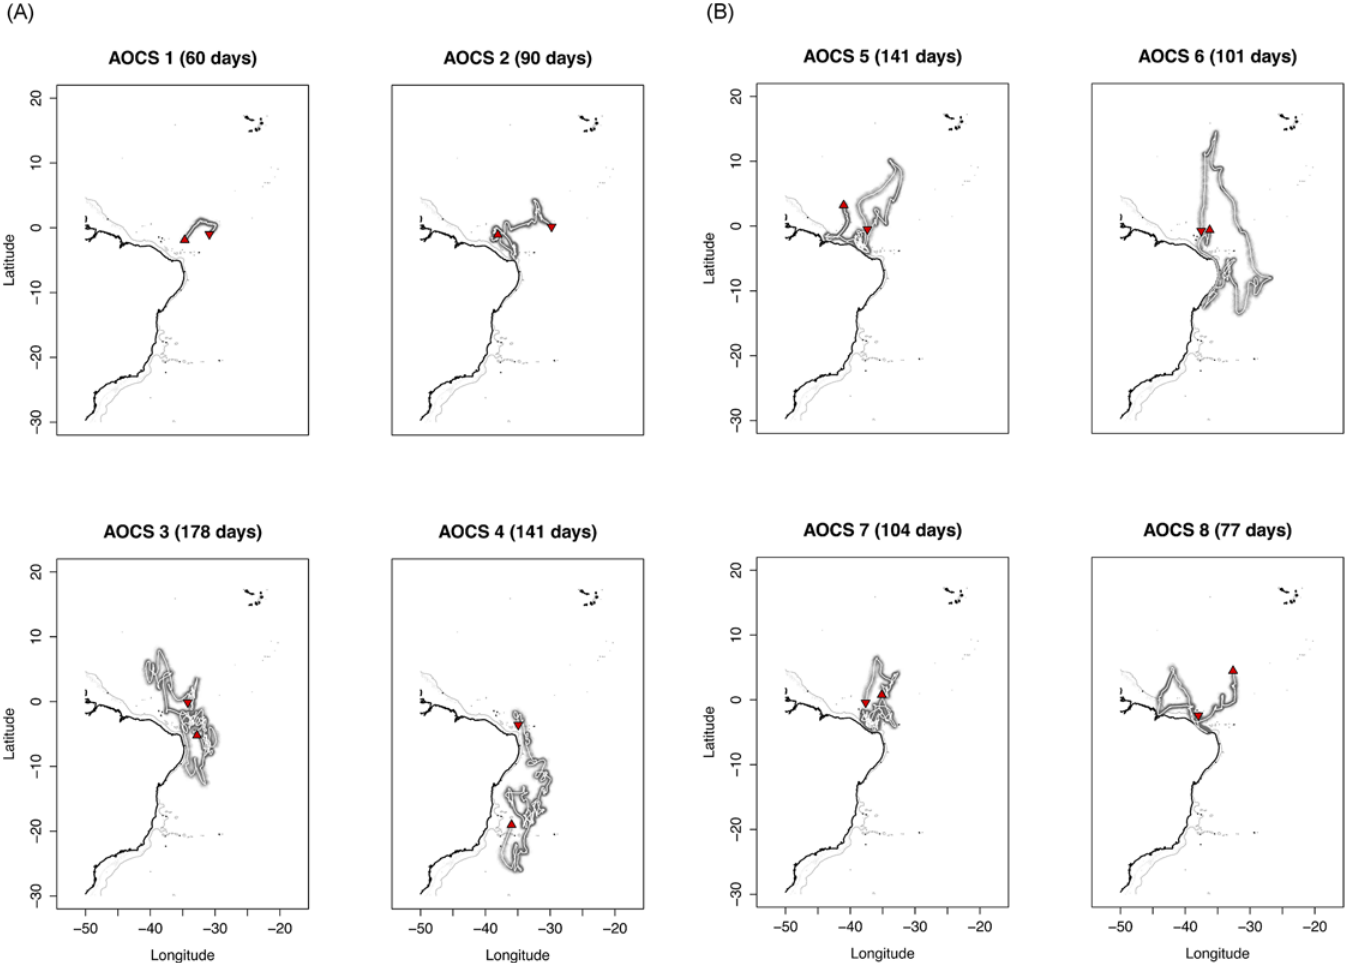
Fig 2. Post-processed tracks of oceanic whitetip sharks tagged in the western Atlantic Ocean. The downward triangles represent the tagging position and the upward triangles the end of the track. The grey-shaded area represents the error around estimated positions. (A) Oceanic whitetip sharks tagged in 2010 and 2011.(B) Oceanic whitetip sharks tagged in